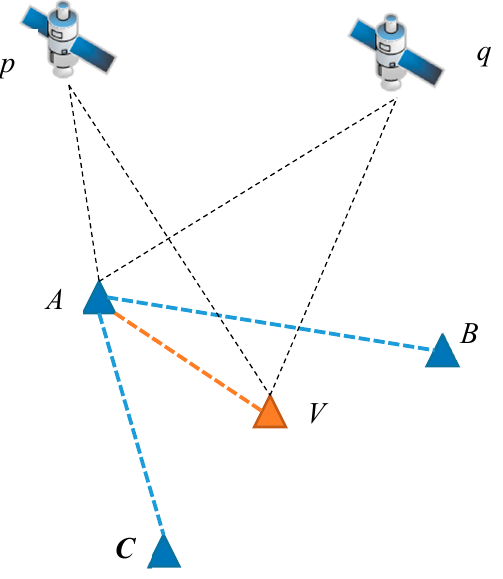
Figure 2. Demonstration of virtual reference station (VRS) generation.